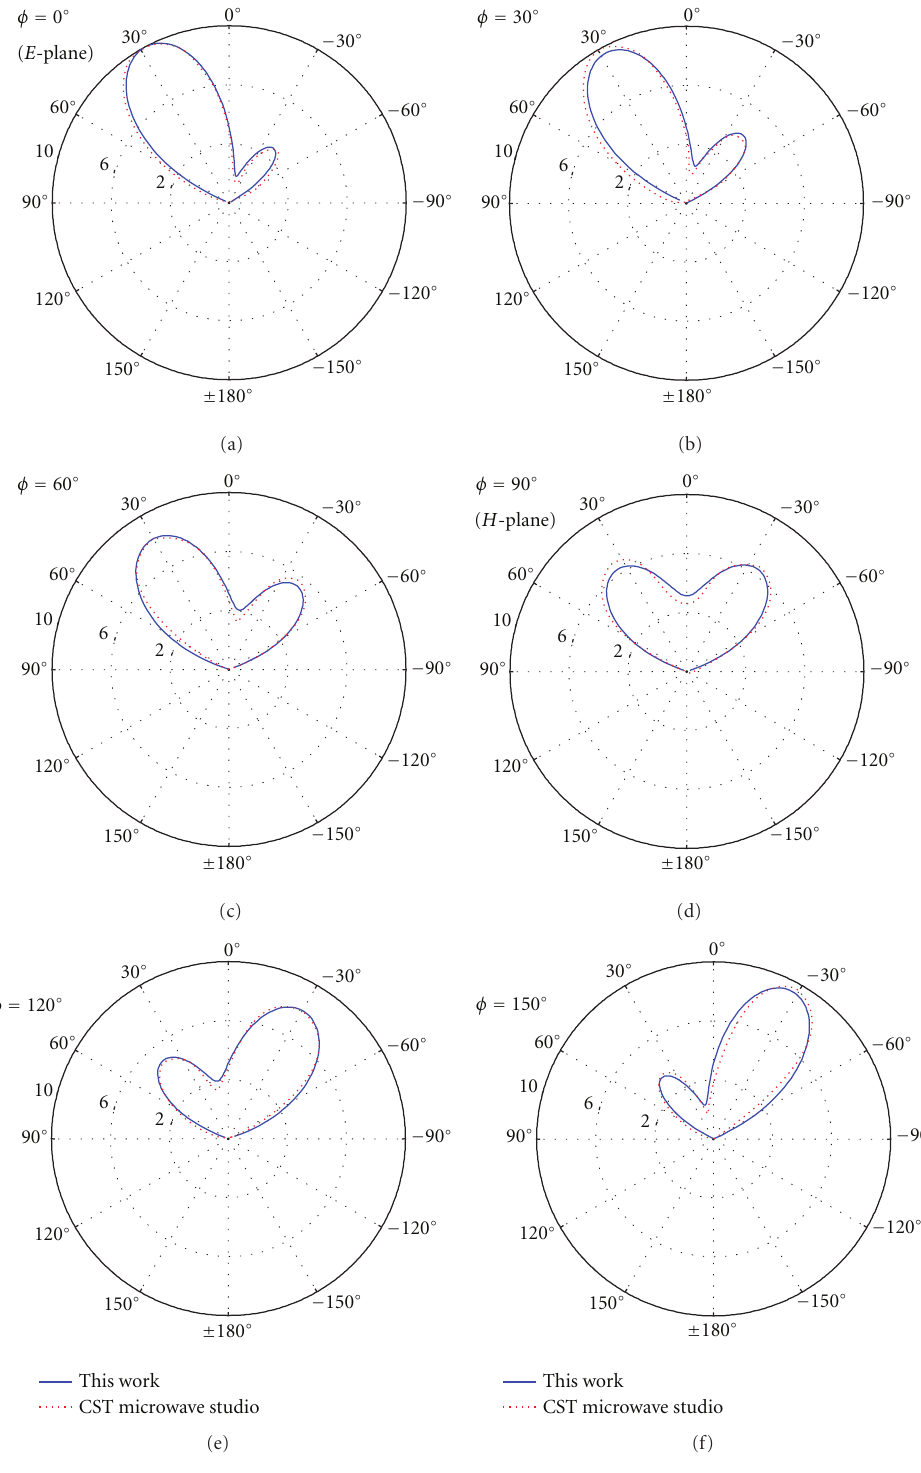
Figure 6: Di ff erent cuts over φ -plane (copolar component of the radiation pattern) for an array with prescribed maximum at φ = 0 and θ = 30 ◦ and a attenuated value 7dB below the maximum at φ = 180 and θ = 30 ◦ . Loading reactances: jX jX = 84 . 39 j Ω , jX = 242 . 69 j Ω , X = 66 . 39 j Ω , and X = − 45 . 83 j Ω . Full-wave results obtained by CST Microwave Studio have been 3 4 5 6 included for comparison